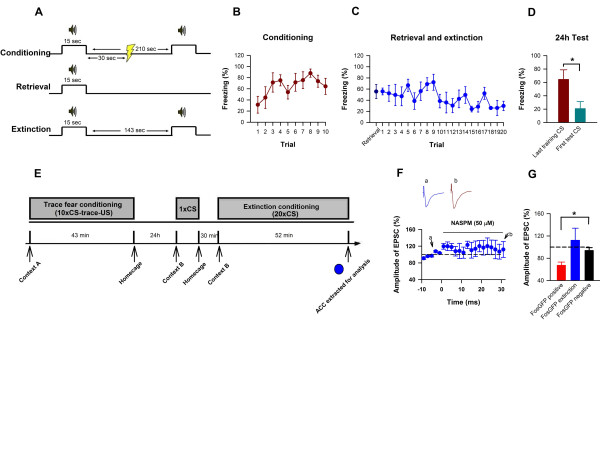
Reconsolidation update eliminates NASPM sensitivity in ACC pyramidal neurons. (A) Reconsolidation update protocol. (B-D) Reconsolidation update robustly extinguishes trace fear memory recall. (E) We extracted the ACC of mice immediately following reconsolidation update of trace fear memory. (F-G) Reconsolidation update abolishes NASPM sensitivity of layer II/III pyramidal neurons in the ACC induced by trace fear memory conditioning, (FosGFP positive extinction: n = 4; FosGFP negative: n = 9, t = -2.38). (G includes FosGFP positive conditioning mean from Fig 5 for comparison). (* P < 0.02).